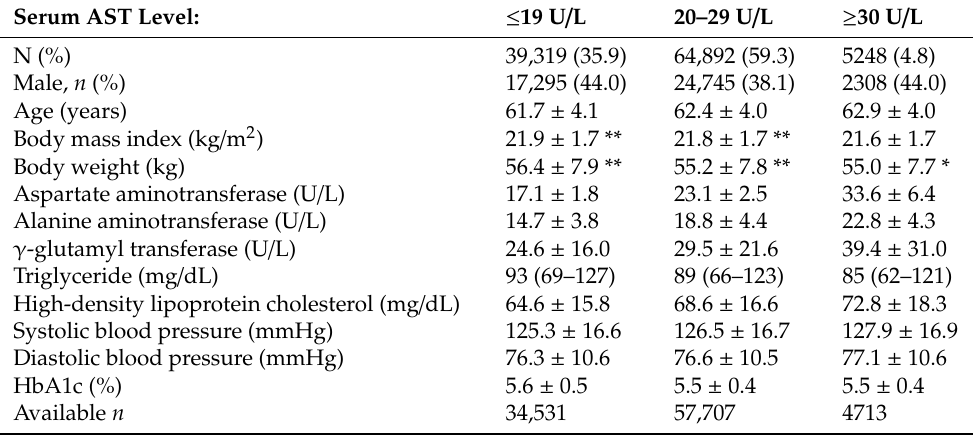
Table 2. Baseline characteristics of older